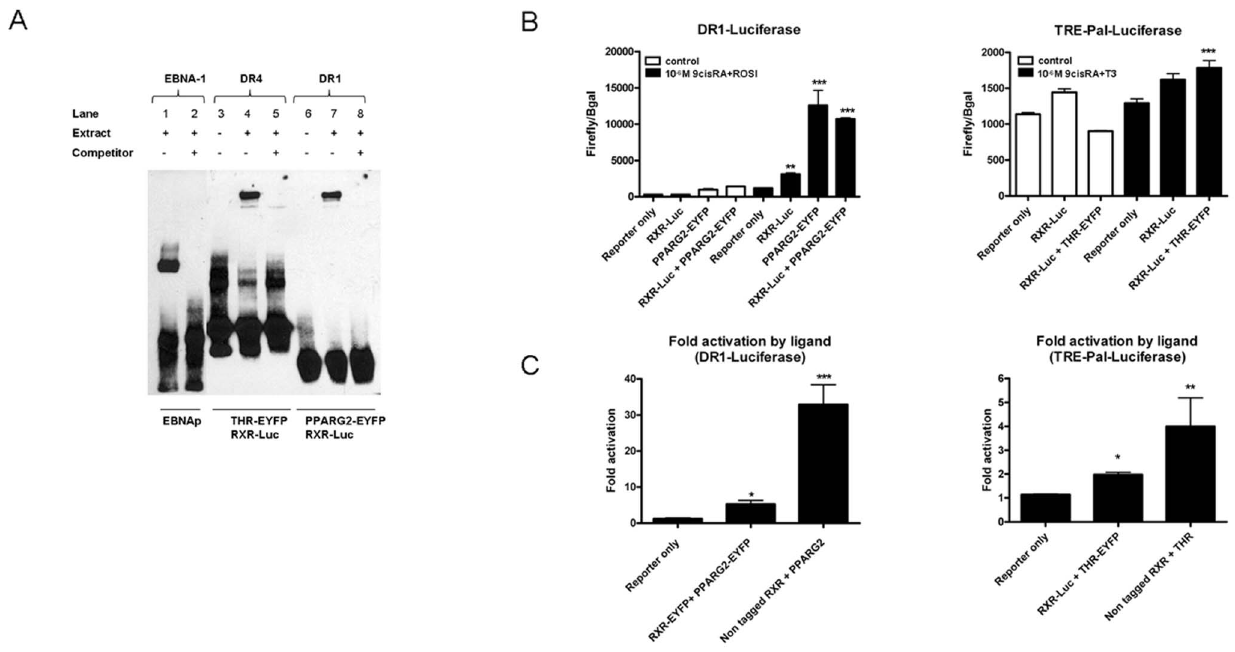
Figure 2. Functional validation of NR fusion proteins. (A) Electrophoretic mobility shift assay (EMSA) experiments with NR fusion proteins encoding RXR-Luc, THR-EYFP and PPARG2-EYFP. Nuclear extracts were prepared from HEK293T cells co-transfected with RXR-Luc and THR-EYFP or RXR-Luc and PPARG2-EYFP encoding plasmids. Several biotinylated RE oligonucleotides were mixed with nuclear extracts containing overexpressed NR fusion proteins: A DR4 probe was used to test the DNA binding of RXR-Luc + THR-EYFP (lane 4), and a DR1 probe was used for RXR-Luc + PPARG2- EYFP (lane 7). In the absence of nuclear extracts no signal was obtained (lanes 3 and 6). As a positive control for EMSA, a biotin-labeled 60 bp duplex bearing the Epstein-Barr Nuclear antigen 1 (EBNA-1) binding sequence was incubated with an extract containing the EBNA protein (lane 1). For each condition, the specificity of the gel shift experiment was determined by the addition of a 200-fold excess of the corresponding unlabeled double stranded consensus sequence (lanes 2, 5 and 8). (B) Histograms represent transcriptional activity of NR fusion proteins RXR-Luc, PPARG2-EYFP (left) or RXR-Luc and THR-EYFP (right) monitored with gene reporters containing DR1 responsive elements or thyroid responsive element palindomic (TREPAL) in their promoters: Hela cells were transiently transfected with RXR-Luc and PPARG2-EYFP or RXR-Luc and THR-EYFP expression plasmids together with a PPAR DR1 (left) or a TREPAL firefly luciferase gene reporter construct (right), respectively. A pCMV- b -galactosidase plasmid was used for normalization. 6 hours after transfection some cells were stimulated 24 h with 10 2 6 M rosiglitazone (ROSI) or 10 2 6 M of triodothyronine (T3) and 10 2 6 M of 9cis retinoic acid (9cis RA). After cells lysis, transcriptional activity was measured by monitoring firefly luciferase activities normalized by b - galactosidase activities. (C) Histograms represent transcriptional fold activation by ligand of transfected tagged constructs, RXR-Luc and PPARG2- EYFP (left) or RXR-Luc and THR-EYFP (right) compared to non tagged plasmids. Values shown are mean 6 SD. (n=2–3). Statistical differences were analyzed by one-way ANOVA followed by Bonferroni’s post hoc test: *P , 0.05; **P , 0.01; ***P ,